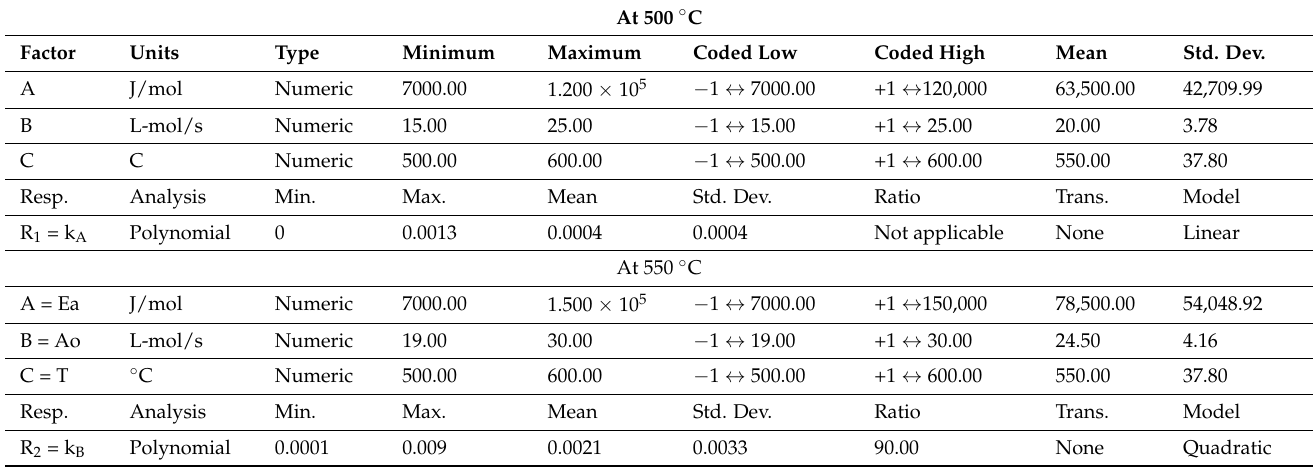
Table 2. The factors and responses for the predicted model. At 500 ◦